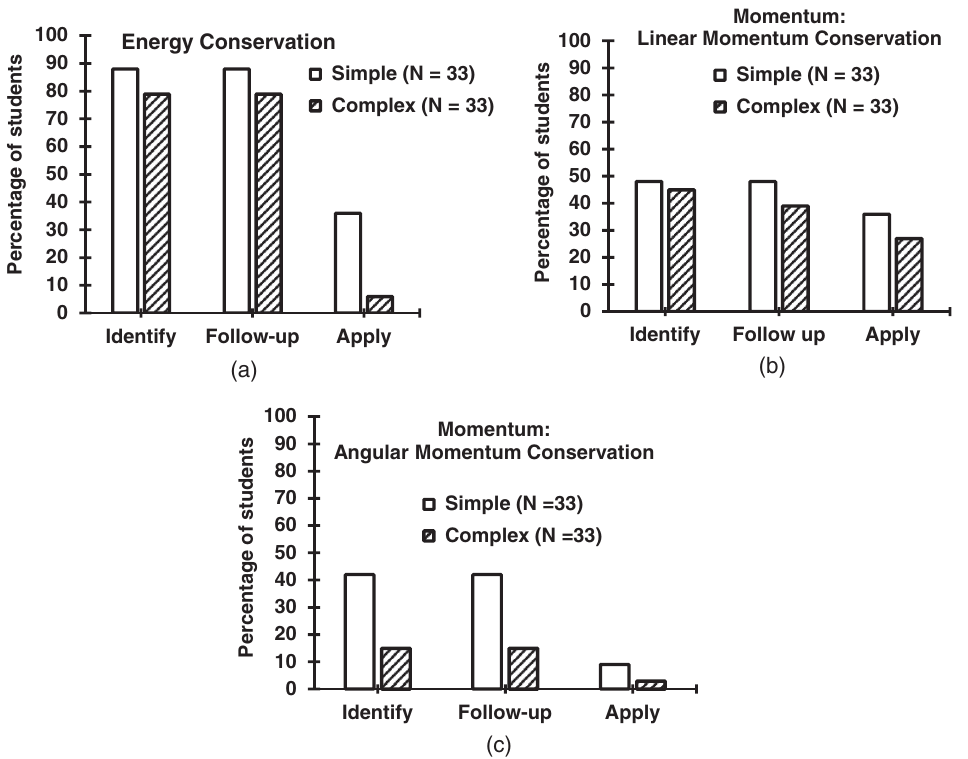
FIG. 11. Conceptual performance on simple and complex simultaneous synthesis tasks for (a) energy transfer, (b) translational motion, and (c) rotational motion.